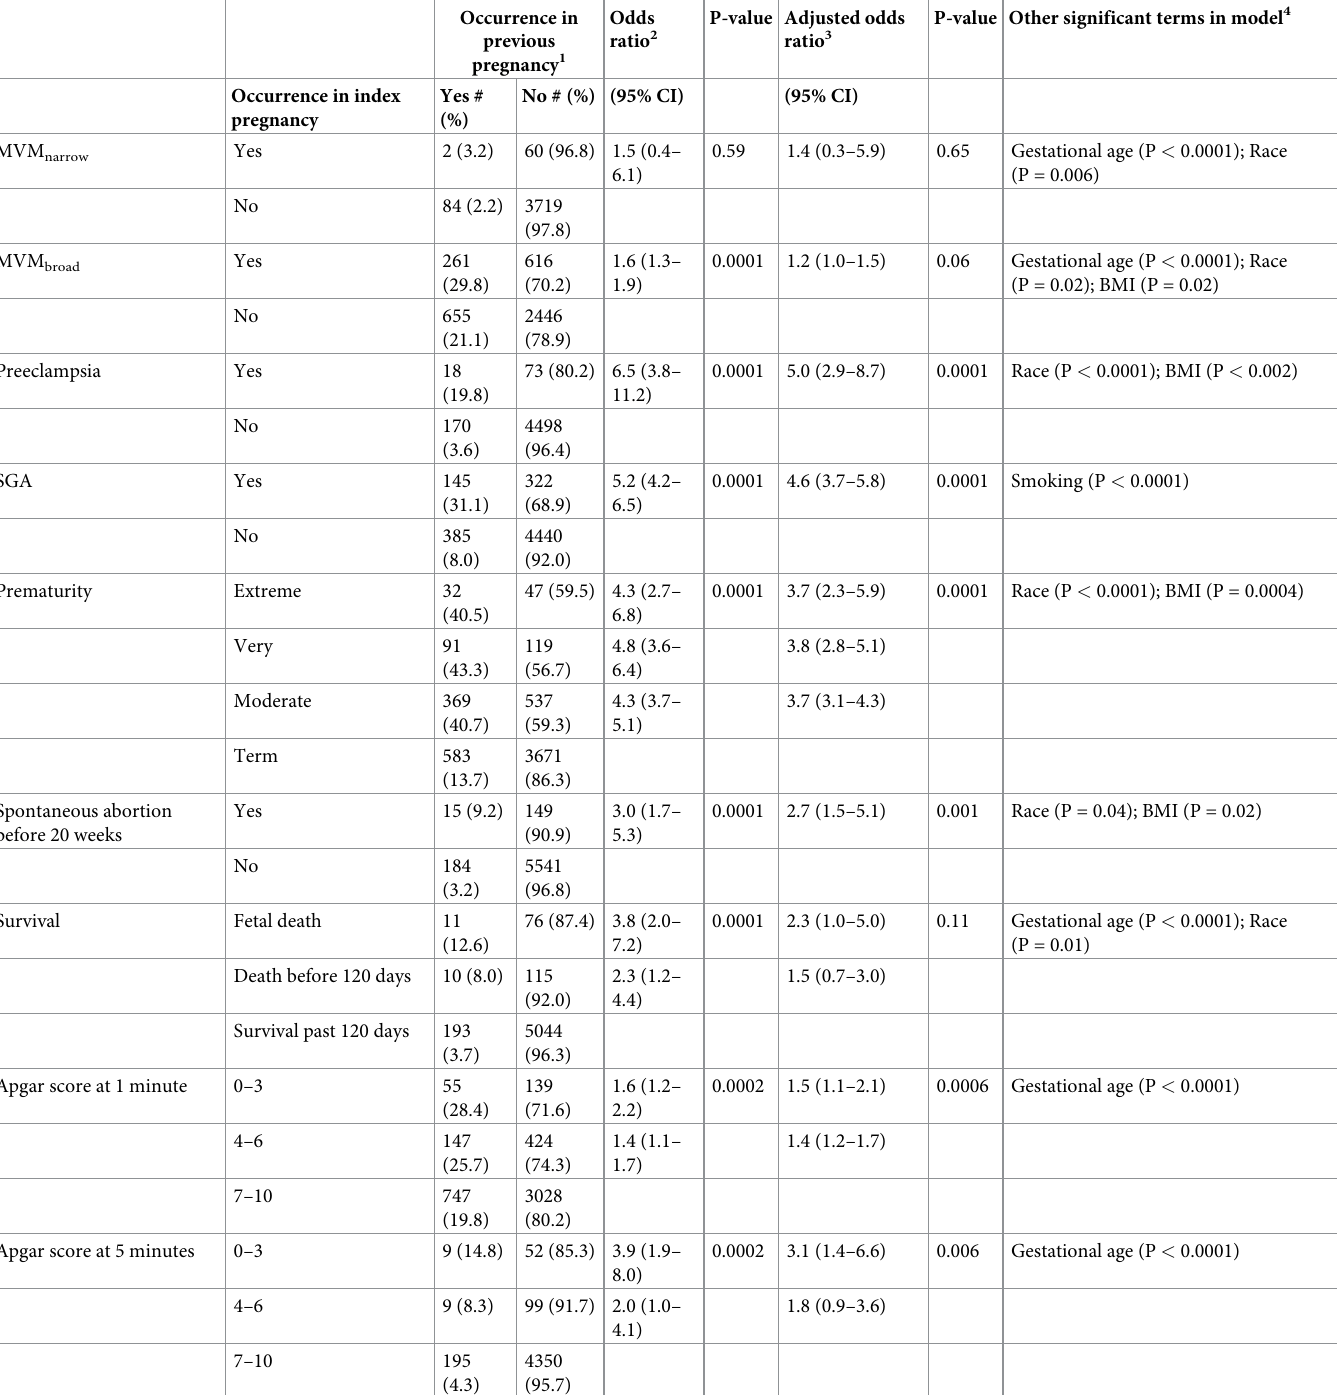
Table 2. Recurrence of MVM and pregnancy outcomes between